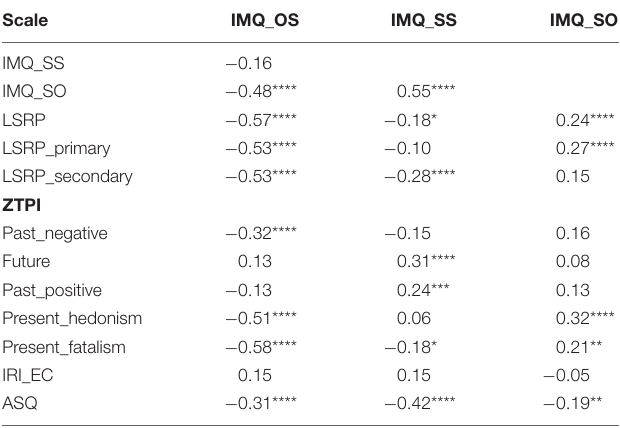
TABLE 3 | Correlations of IMQ subscales with other measures: Sample